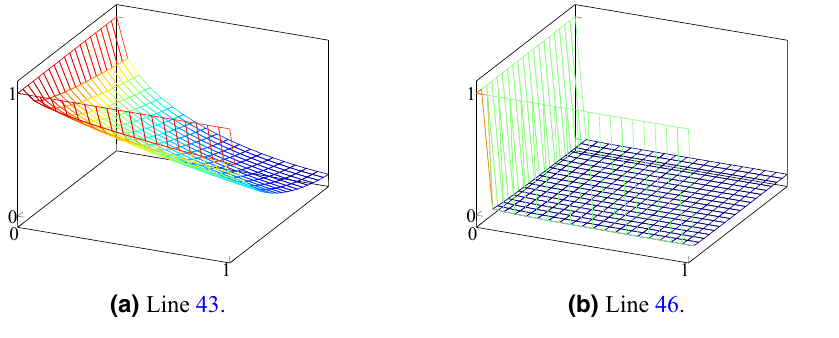
Figure 17. Proposed functions from Algorithm